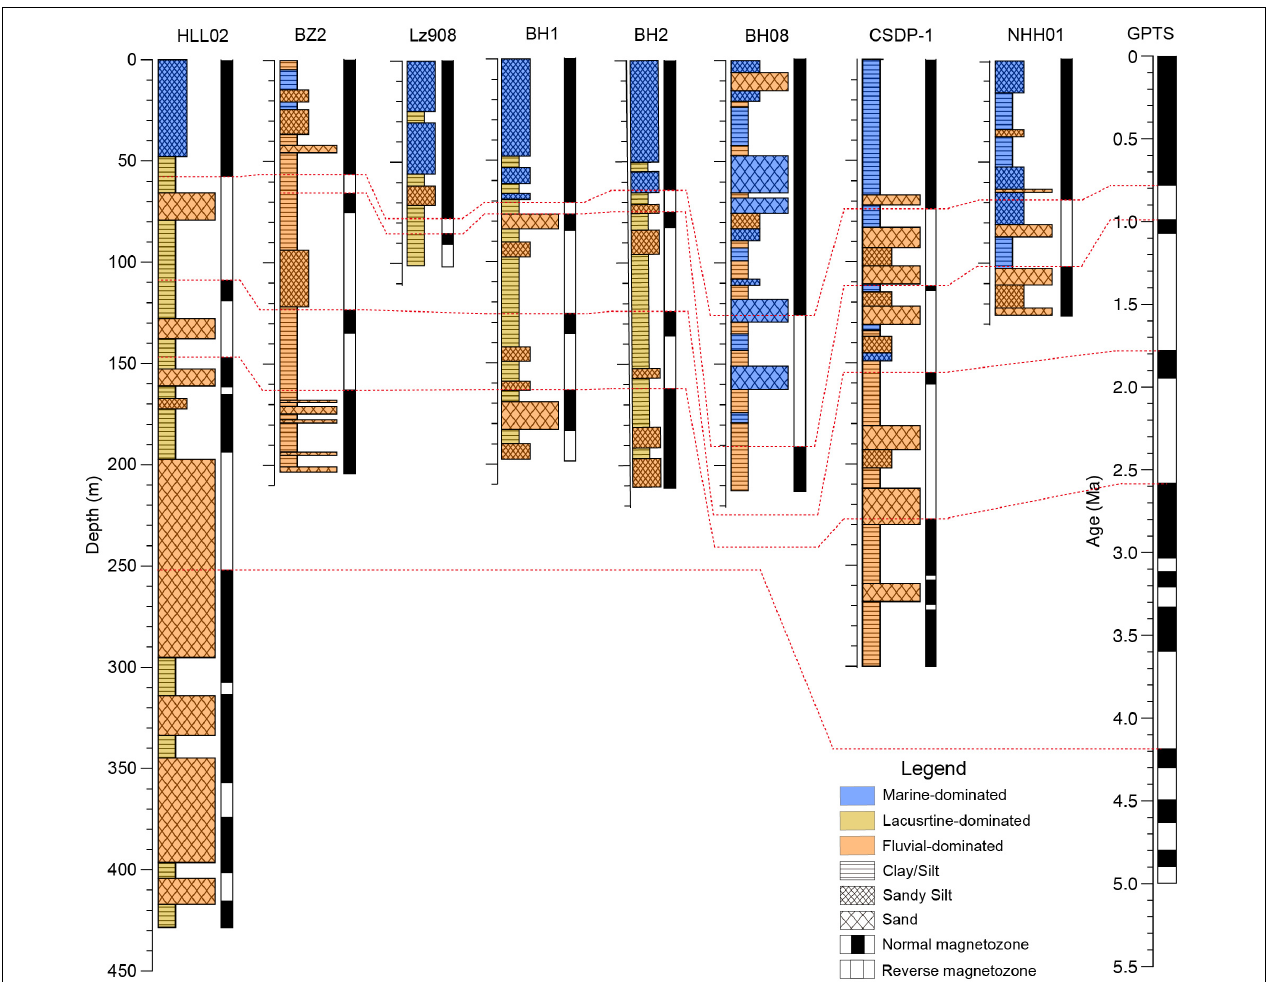
FIGURE 5 | Comparison of lithostratigraphy and magnetostratigraphy of long sediment cores from the Bohai Sea, Yellow Sea, and coastal plain. Data for core BZ2 are from Yao et al. (2010, 2012), BH1, BH2, and HLL02 from Yi et al. (2016), Lz908 from Yi et al. (2015), NHH01 from Liu et al. (2014), CSDP-1 from Liu S. et al. (2016) and Liu et al. (2018). The GPTS is from Gradstein et al. (2012).